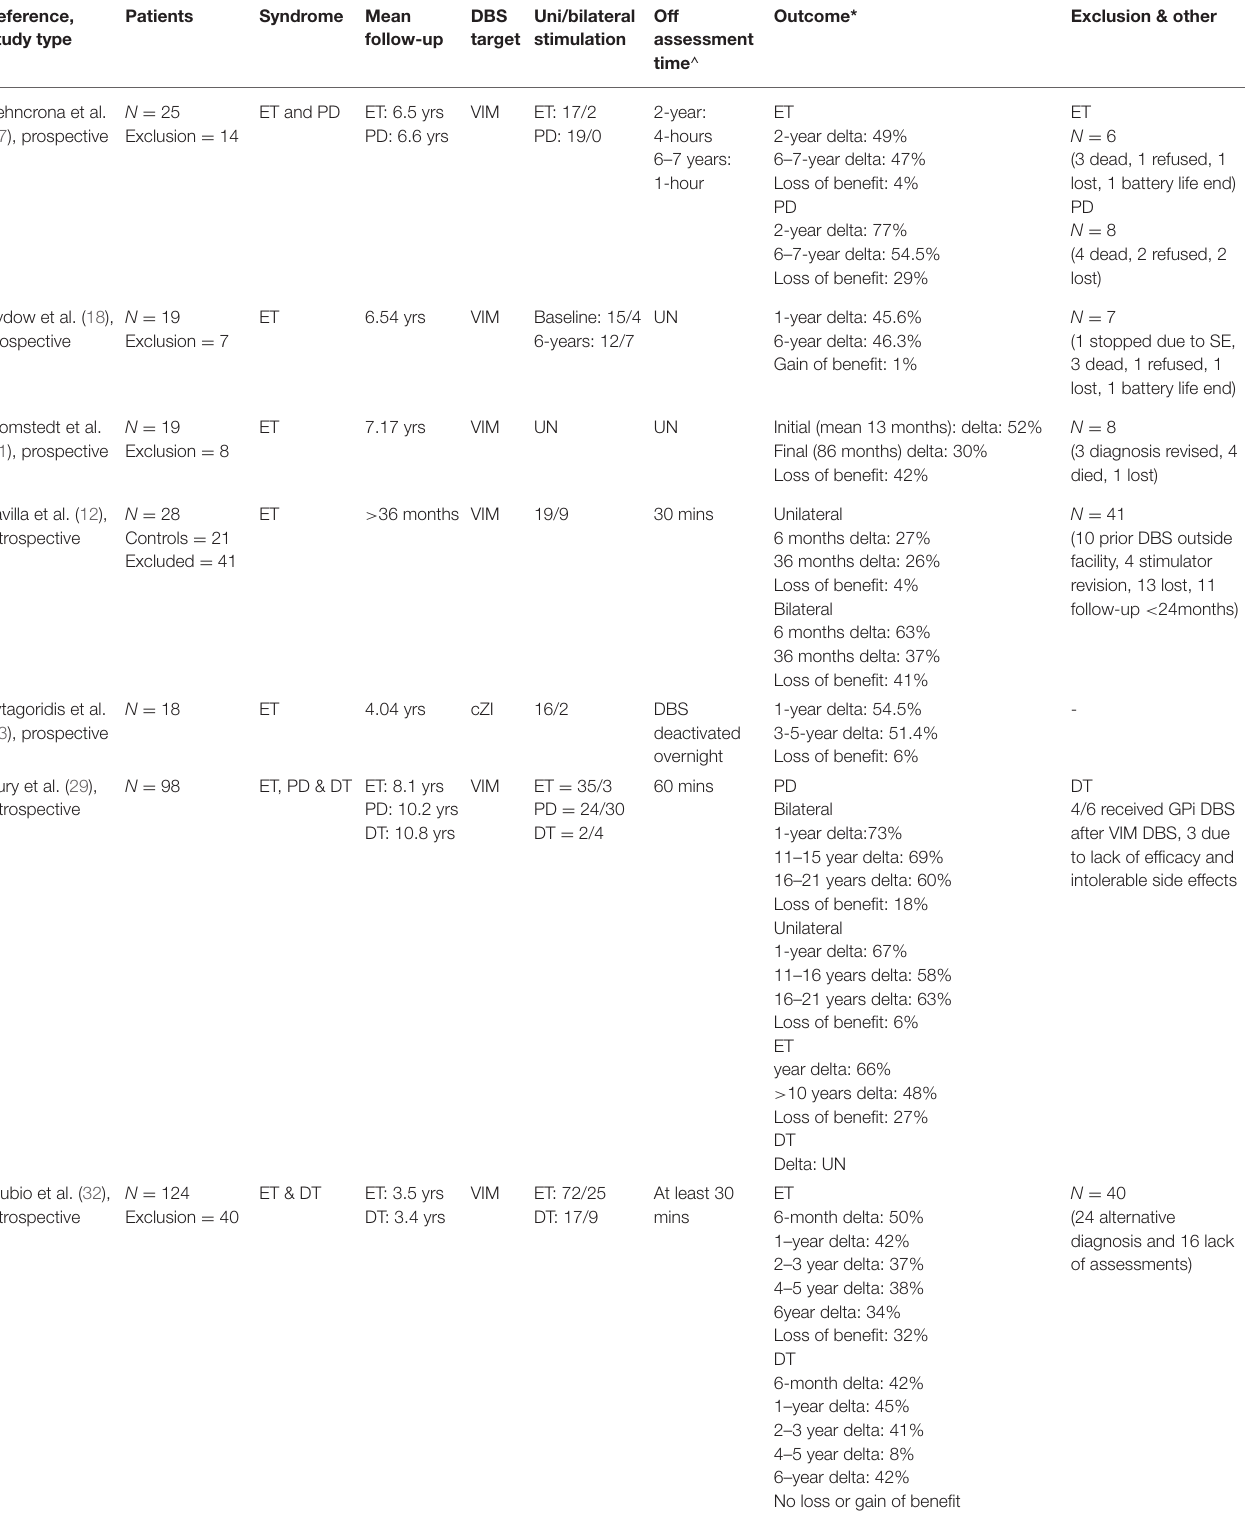
TABLE 1 | The change in deep brain stimulation effect in long term studies of Essential Tremor. Reference, Study